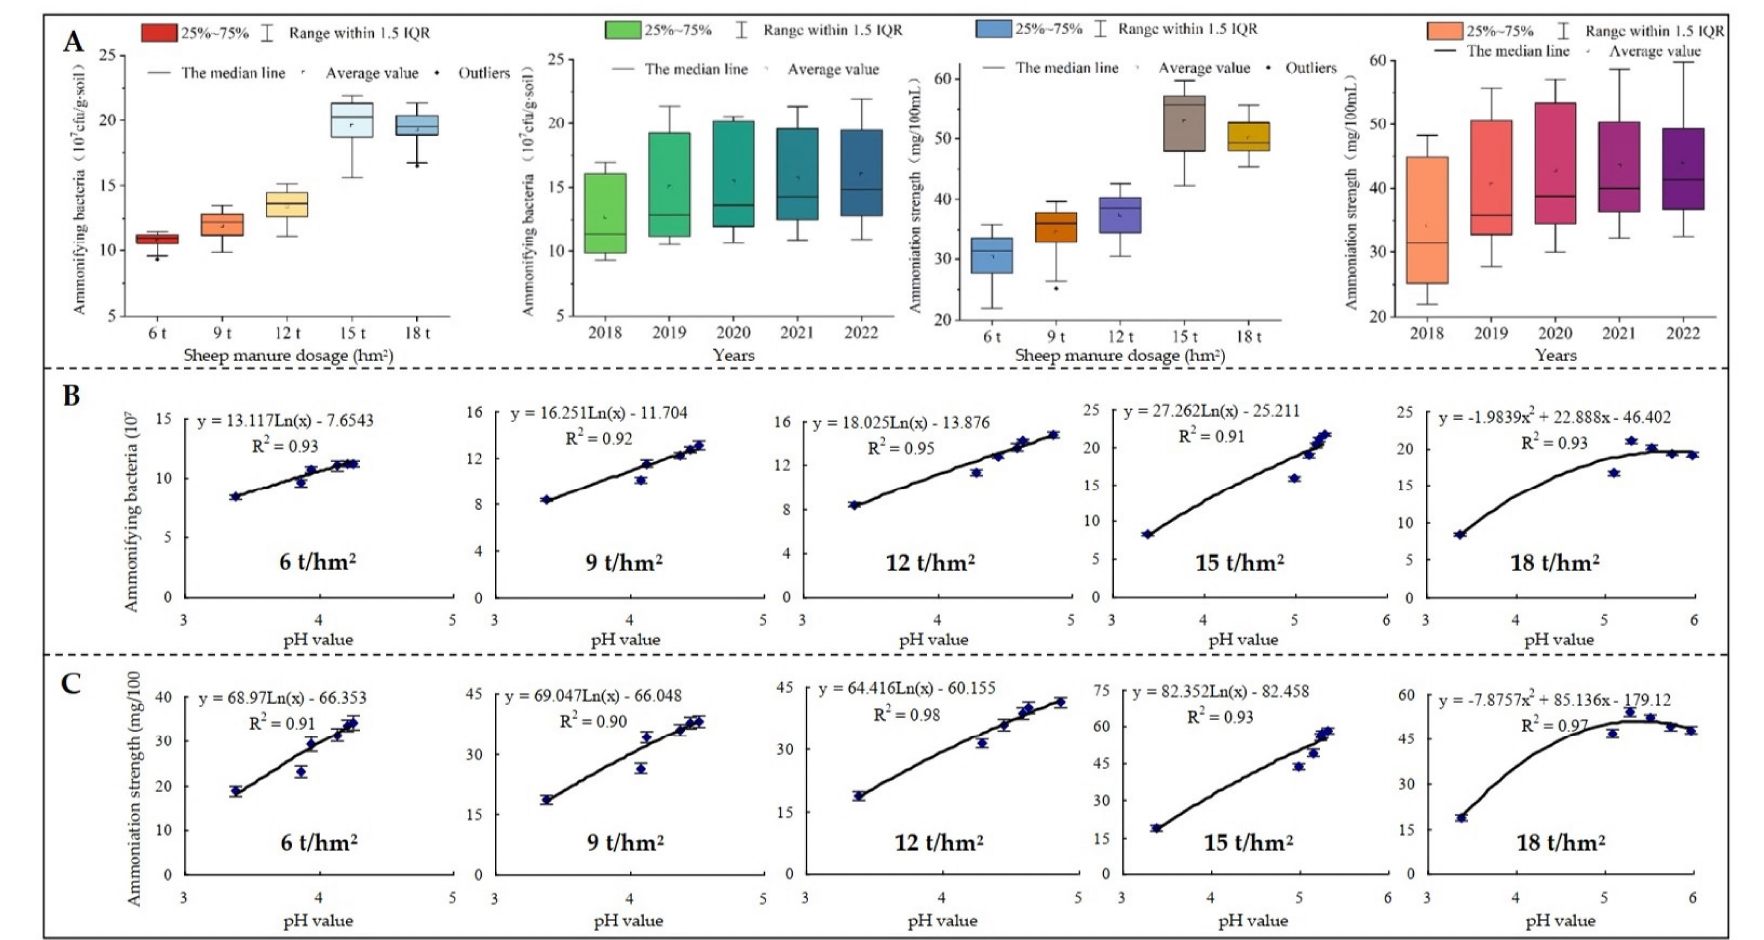
Figure 5. Effects of sheep manure fertilizer and pH value on the number of ammonifying bacteria and ammoniation strength in tea plantation soil. ( A ) Effects of sheep manure fertilizer on the number of ammonifying bacteria and ammoniation strength in tea plantation soil; ( B ) effect of pH value on the number of soil ammonifying bacteria in tea plantation after a continuous use of sheep manure fertilizer for 5 years; ( C ) effect of pH value on soil ammoniation strength in tea plantation after a continuous use of sheep manure fertilizer for 5